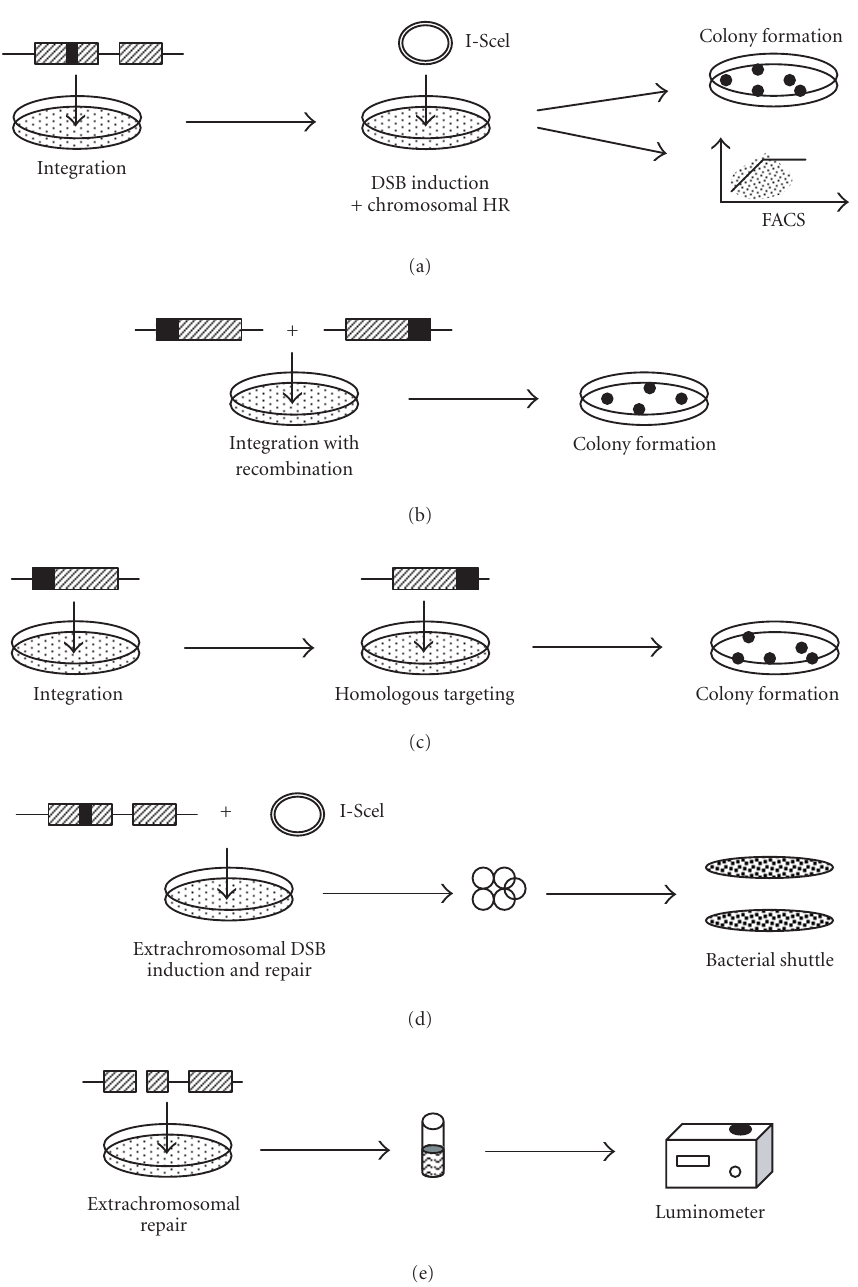
Figure 1. Illustration of the principles of measuring HR with plasmid assays. (a) Chromosomal DSB repair assay [14, 15]. A linearized plasmid substrate containing mutated resistance or marker genes is transfected and stable chromosomal integrants are selected, for example, using a puromycin resistance gene. Single-cell derived or pooled populations are amplified, and the integrated plasmid is characterized. Single or multiple copy integrants can be processed. The I-SceI expression vector is transiently transfected and usually 48hours are allowed for the generation and homology-directed repair of I-SceI breaks within the integrated substrate (black insertion). The HR frequency can be assessed by selecting for the recombined antibiotic resistance gene in a colony formation assay (eg, GPT ), or by assaying the marker gene product such as the green fluorescent protein (GFP) via flow cytometry (FACS). (b) Integration-associated HR [18]. The linearized substrates p ∆ 2 and p ∆ 3, each carrying a mutated GPT gene copy (black boxes, gene deletions), are cotransfected. HR before and during plasmid integration leads to the reconstitution of the resistance gene. Drug selection is used for isolation of stable recombinants in a colony formation assay. (c) Homologous gene targeting [29]. Linearized p ∆ 2puro is stably integrated using puromycin. Transient transfection of p ∆ 3 allows for HR between the chromosomal GPT gene copy and the extrachromosomal GPT . The reconstituted GPT gene is selected for using colony formation. (d) Episomal HR with replication [30]. An episomally replicating recombination substrate carrying mutated tandem repeats of a CAT reporter is transiently transfected together with an I-SceI expression vector. Breaks are generated within one CAT copy (black insertion) and repaired via HR using a downstream homologous template. After 48hours, episomal plasmids are extracted and tested for the functional CAT gene in a bacterial shuttle vector assay. (e) Extrachromosomal HR. The mutated recombination substrate ( CAT or Luciferase gene) is cut prior to transfection. HR reconstitutes the gene function, which can be measured by assaying cell extracts in a luminometer or scintillation